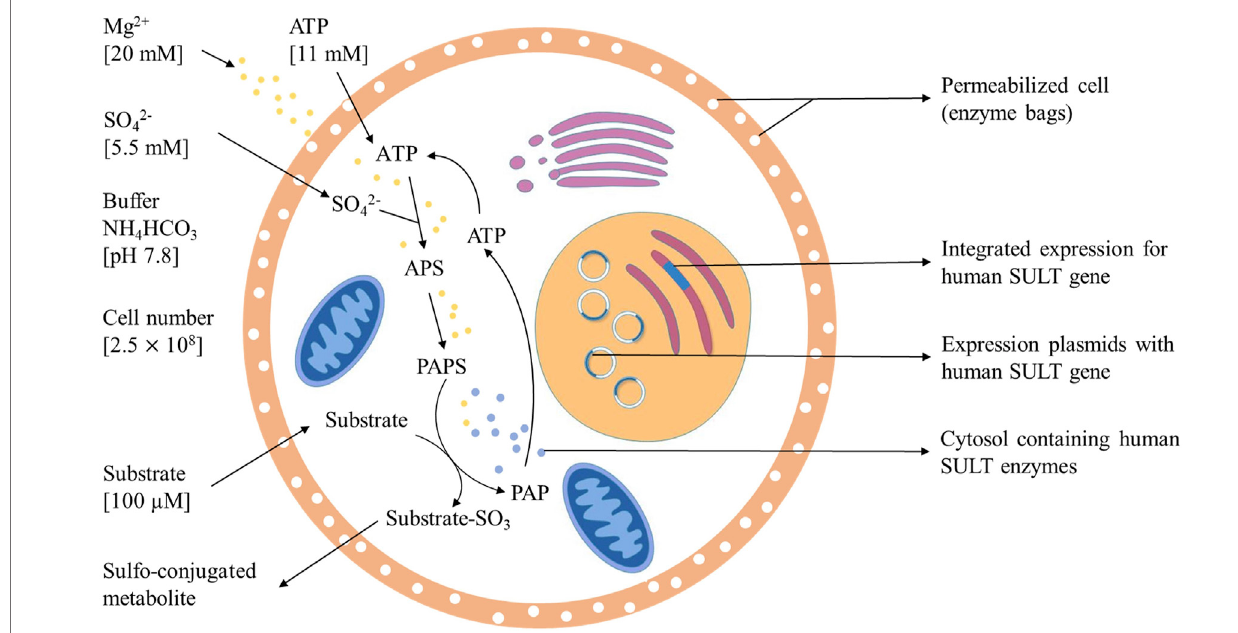
FIGURE 7 | Optimized method for sulfotansferase catalyzed metabolite generation including PAPS replacement protocol.